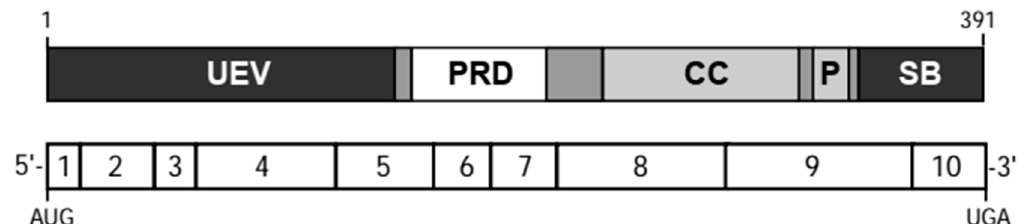
Figure 1. Schematic of the functional domains of the mouse TSG101 protein and their location within the 10 coding exons of the spliced mRNA. UEV, ubiquitin-conjugating enzyme E2 variant; PRD, proline-rich domain; CC, coil-coiled domain; P, conserved PTAP tetrapeptide motif; SB, steadiness box .